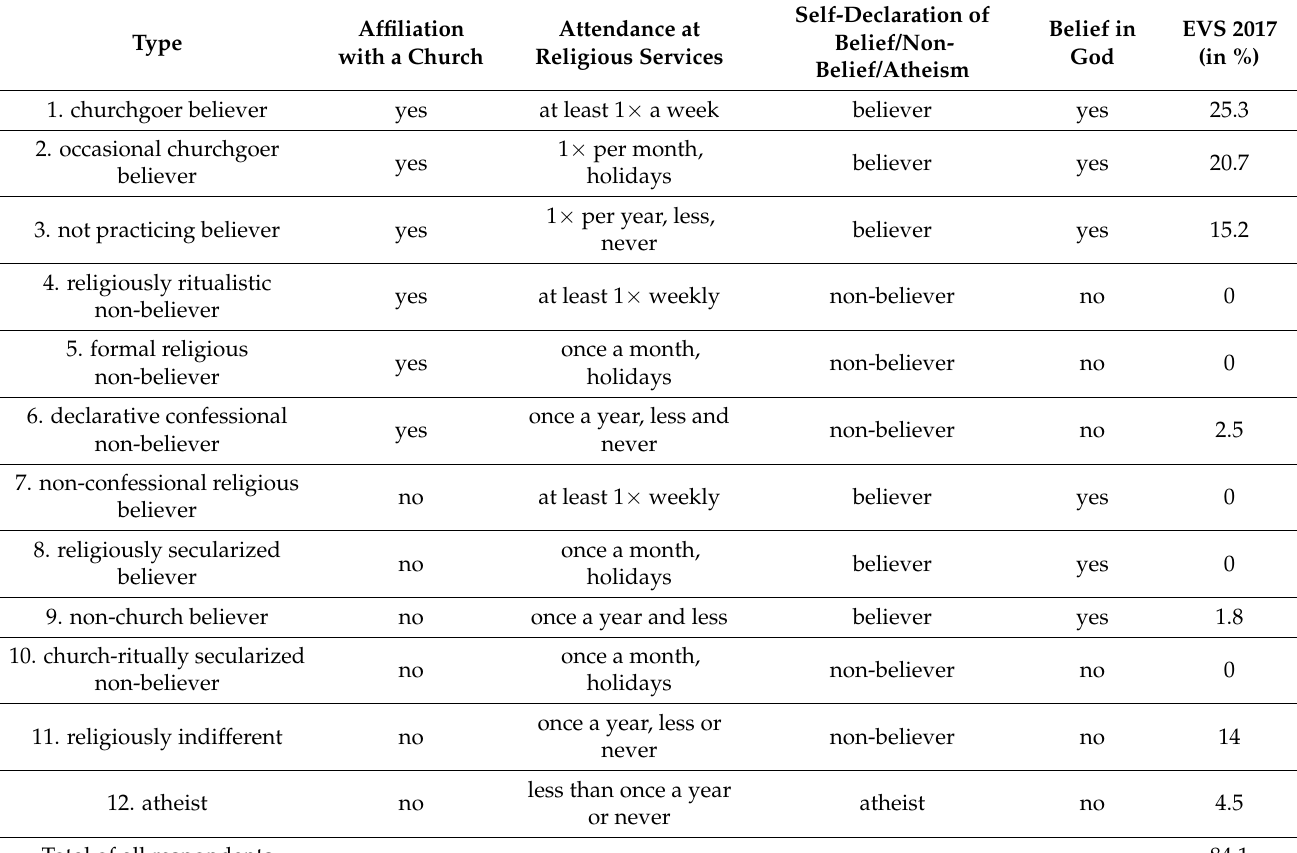
Table 3. Saturation of theoretical types of